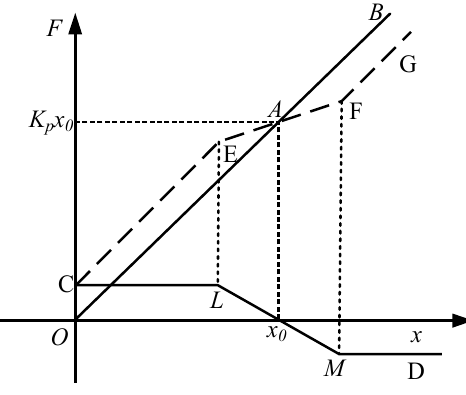
Figure 2. Force–displacement curves indicating the principle of EANSG.